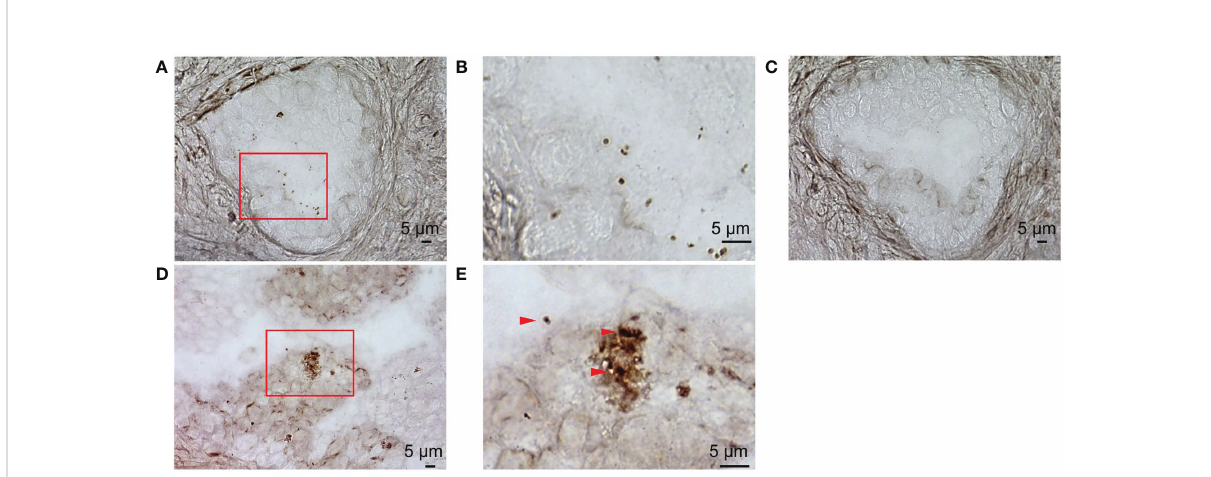
FIGURE 3 ISH with EUB338 probe (eubacteria speci fi c) and NON338 (negative probe for eubacteria) on human prostate serial slices. (A) ISH with EUB338 probe. (B) Magni fi cation of the red enclosed area in (A, C) ISH with NON338 probe. (D) Gram stain and ISH with EUB338 probe. (E) Magni fi cation of the red enclosed area in (D) The Gram-stained and Ni-enhanced DAB colored cells are marked with arrowheads. ISH, in situ